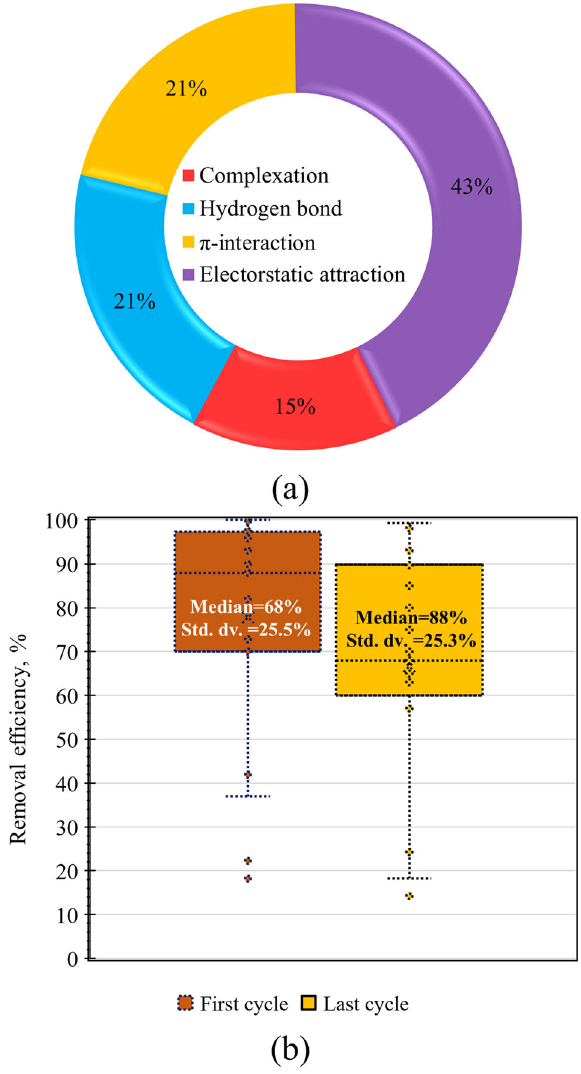
Fig. 5 Summary of organic adsorption ’ s dominant removal mechanisms and regeneration ef fi ciencies. a The electrostatic attraction is the highly dominant adsorption mechanism. b The regeneration performance of dyes was relatively stable. The scatter range indicates relatively high ef fi ciency in the last regeneration cycle. Note that the vertical lines present the deviation from the median